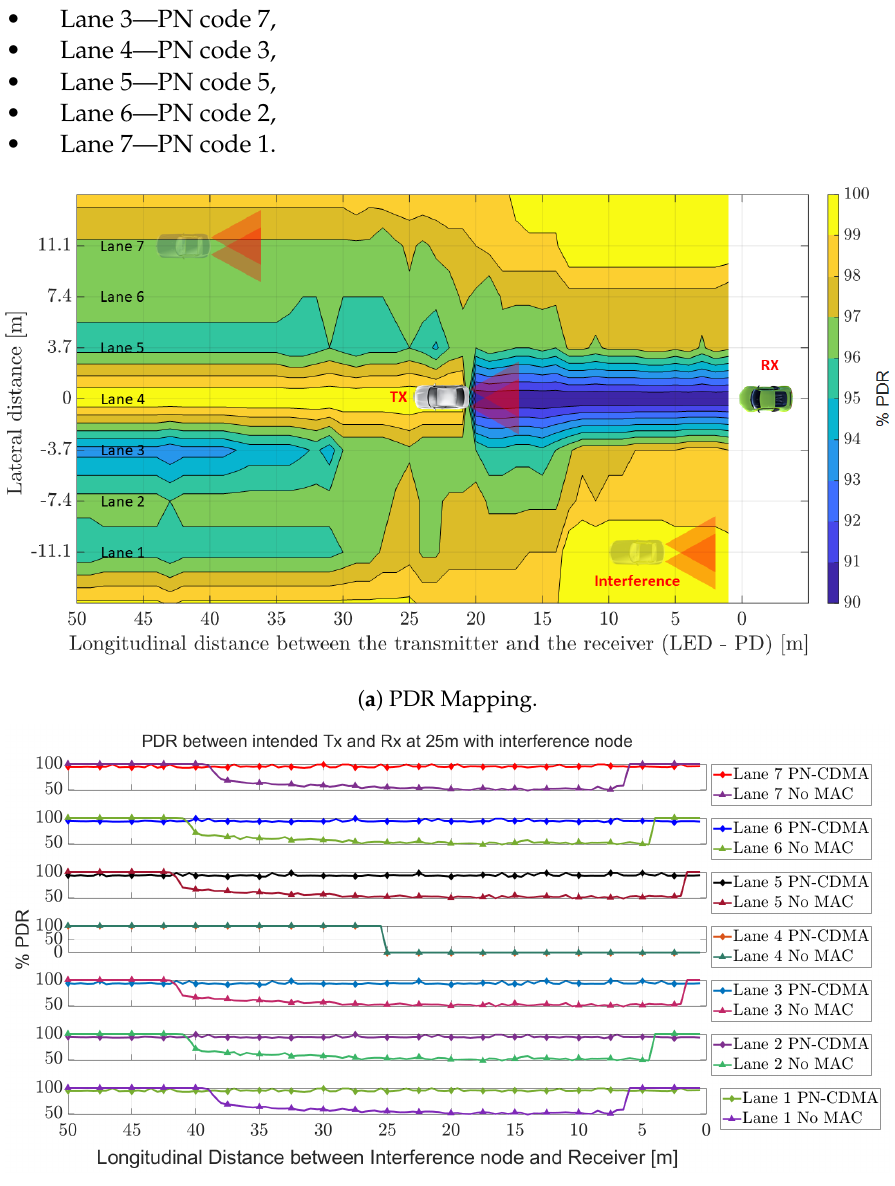
Figure 14. ( a ) View of PDR performance from above with MUI in V2V VLC with PN-OCDMA MAC, when the transmitter and receiver are in the centre lane of a seven-lane road with an inter-vehicle distance of 18 m; ( b ) Details of PDR